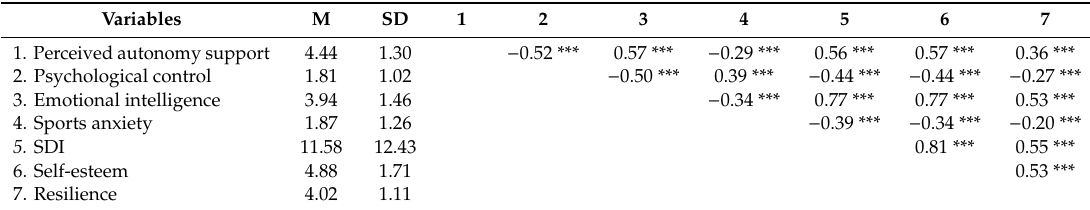
Table 2. Descriptive statistics and correlation between